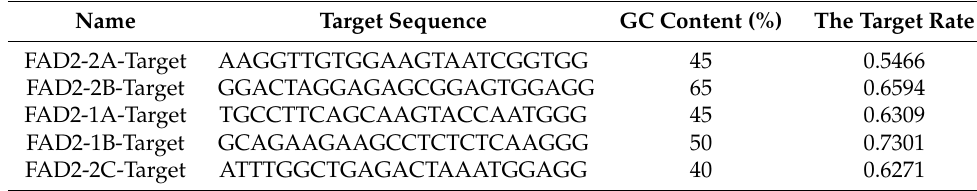
Table 1. gRNA-guided sequence of target